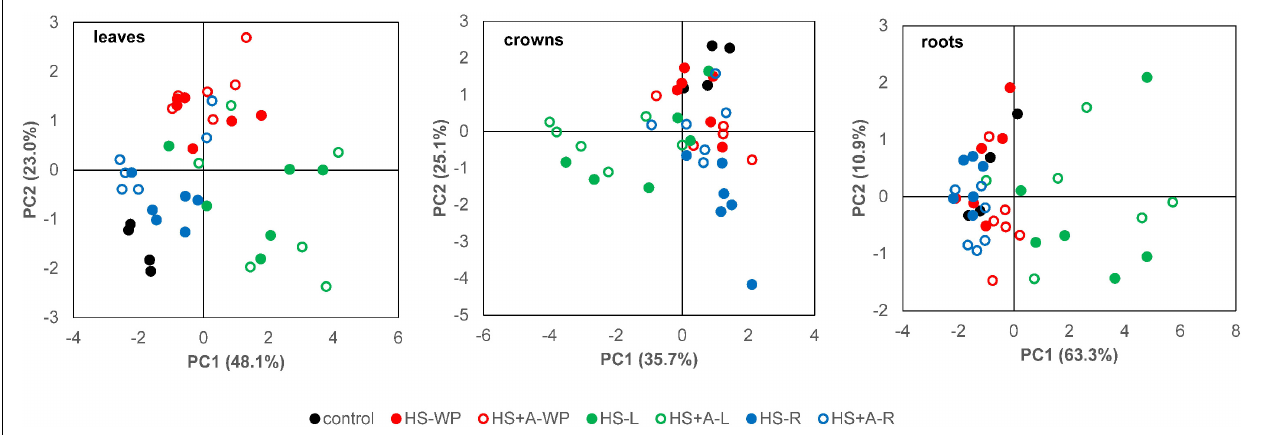
FIGURE 8 | PCA analysis of active hormone levels (ABA, IAA, JA, JA-Ile, SA, tZ, and cZ) in leaves, crowns, and roots of individual samples. Rice seedlings were exposed to heat stress directly (HS) or after acclimation (HS + A). Heat stress was applied to whole plants (WP), leaves (L), or roots (R). Data for PCA were standardised in order to adjust phytohormones of different